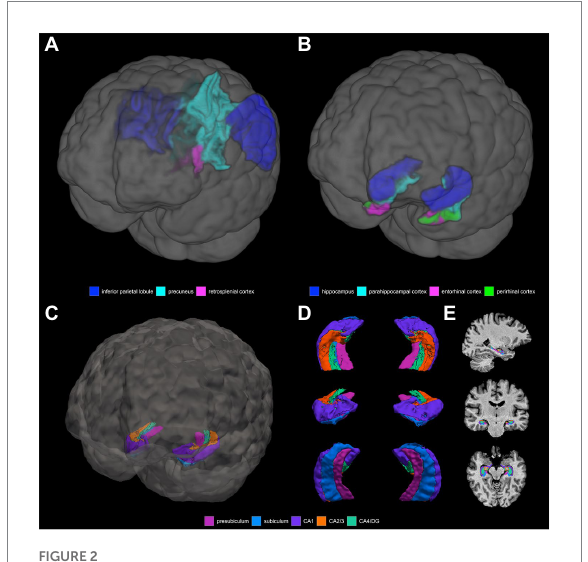
FIGURE 2 3D depictions of (A) areas important for non-standard visuomotor integration, and (B) areas of the medial temporal lobe, used for grey matter volume and cortical thickness analyses. Hippocampal subfields obtained from FreeSurfer segmentation and used for analysis are shown in (C) a 3D brain, (D) 3D superior, anterior, and inferior views, and (E) sagittal, coronal, and axial